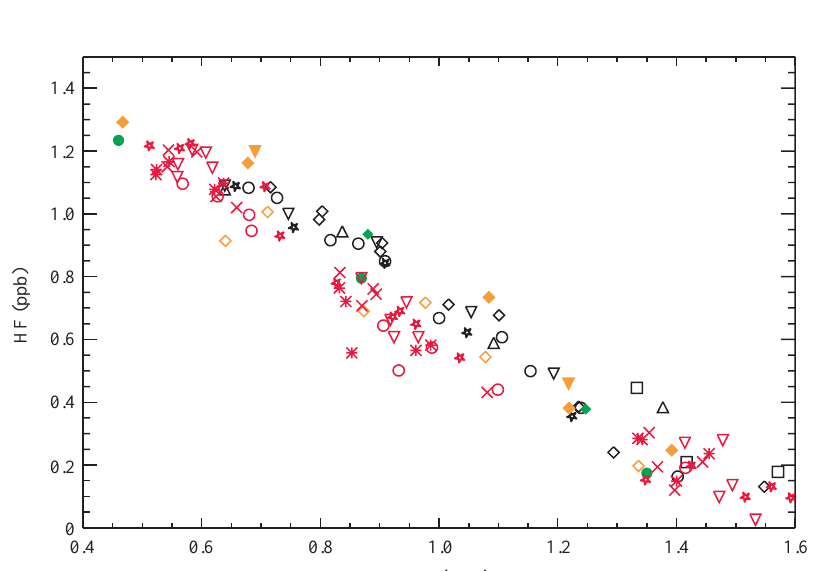
Fig. 6. The relation between CH 4 and HF volume mixing ratios in the Arctic vortex over the winter 1995–96. Black symbols indicate measurements in November 1995, orange symbols in January 1996, green symbols in February 1996, and red symbols in April (1–5) 1996. The conservation is valid for methane mixing ratios of 0.4–1.6 ppmv, corresponding to a potential temperature range (in March and April) of 350–600 K. (The symbols indicate individual days: ( 14-Nov-95; 4 15- Nov-95; (cid:5) 20-Nov-95; (cid:14) 21-Nov-95; r 22- Nov-95; ? 23-Nov-95; H 29-Jan-96; 30-Jan-96; (cid:5) 31-Jan-96; 1-Feb-96; (cid:15) 28-Feb-96; (cid:14) 1-Apr- 96; (cid:3) 2-Apr-96; (cid:2) 3-Apr-96; 4-Apr-96; ? 5- Apr-96)